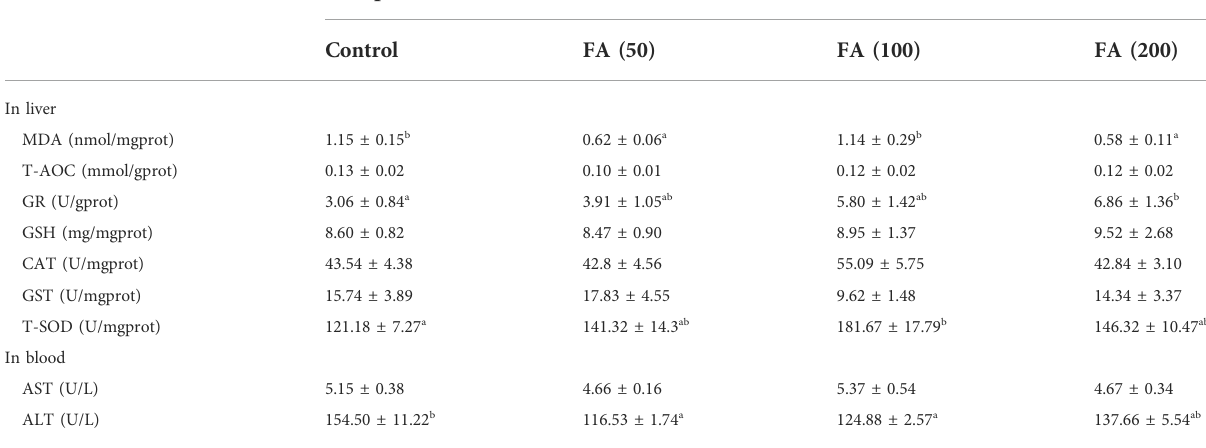
TABLE 5 Indicators re fl ecting liver antioxidant capacities and liver health in juvenile grass carp fed diets containing graded levels of FA.